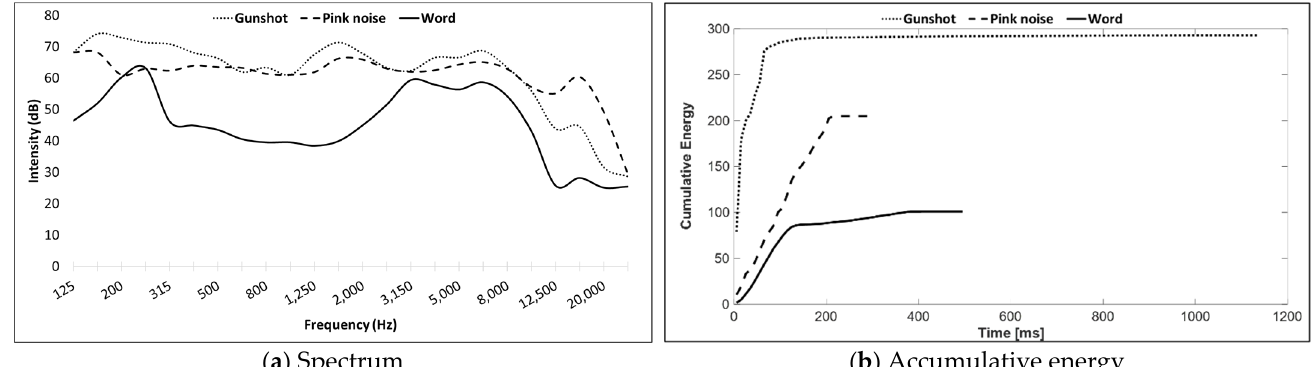
Figure 1. Description of Hebrew word /esh/ (fire), pink noise, and M16 single gunshot at a distance of 200 feet (60.96 m) .